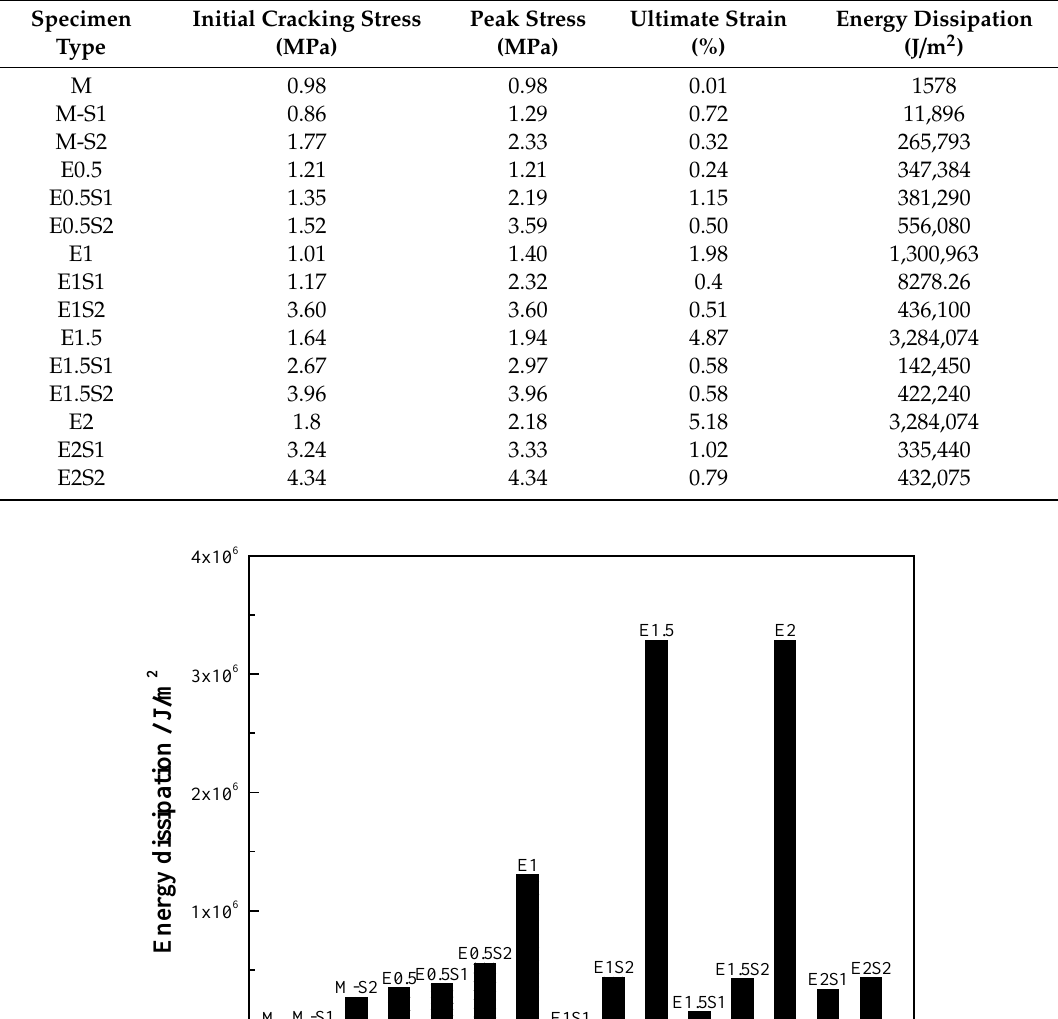
Table 8. Quasi-static tensile test results of the steel grid-PE fiber reinforced ECC.